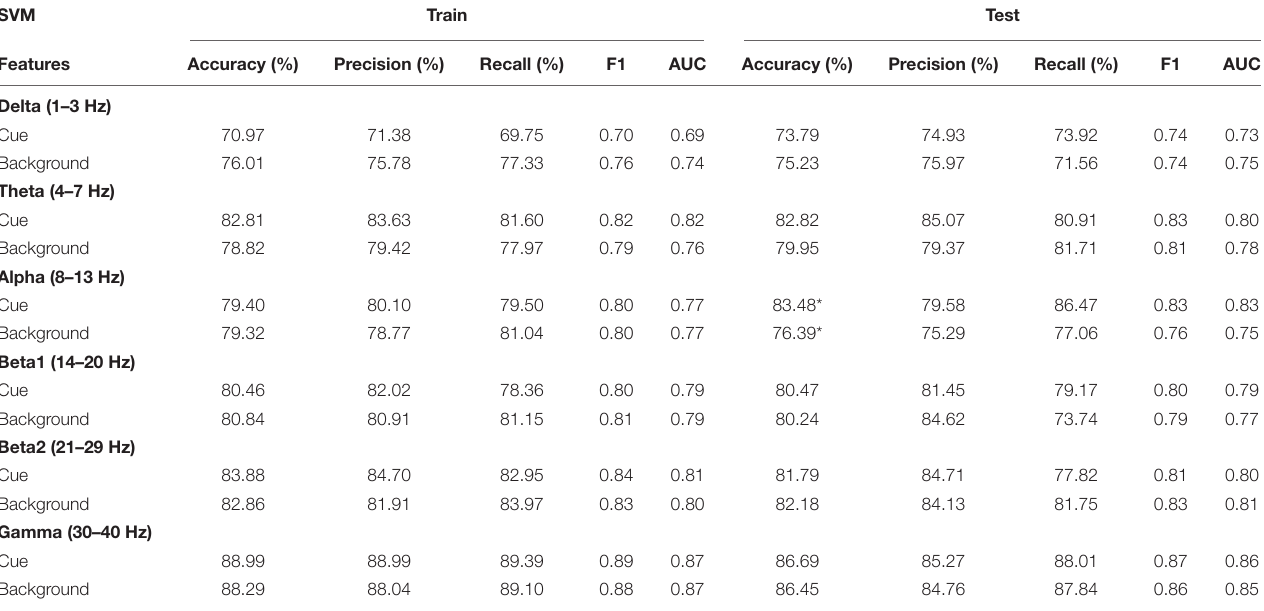
FIGURE 4 | Model accuracy of classification of FR and noFR in the test set. Results were obtained by SVM model trained by features of each frequency band respectively ( δ , θ , α , β 1, β 2, and γ ) in each condition (cue and background). The error bars are standard deviations. *** p < 0.001 for t -test between models in two conditions on each band. • Marks the good models whose test accuracy > 85%. TABLE 4 | Results of classifying FR and noFR based on each frequency